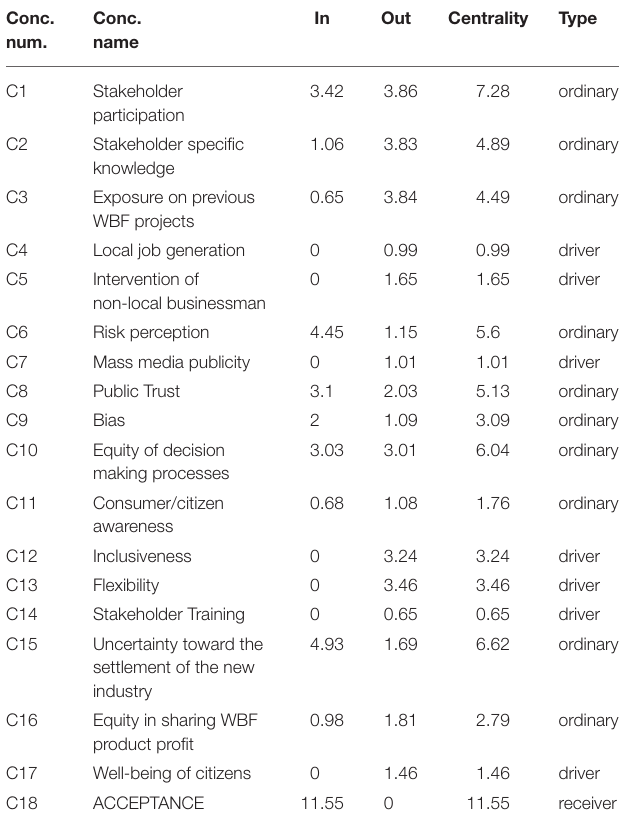
TABLE 4 | InDegree, OutDegree, Centrality and Type of Concepts in the Social_FCM. Conc. num.